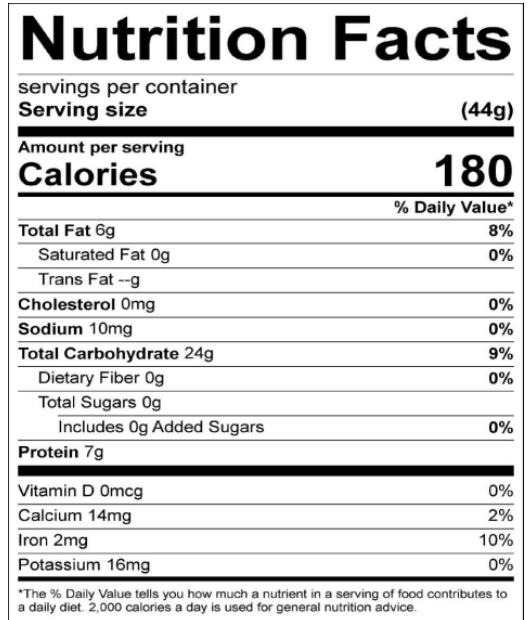
Figure 3. Food label for Recipe 5.